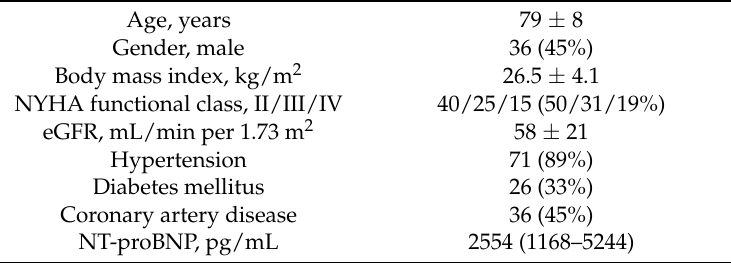
Table 1. Demographic and clinical characteristics of the study